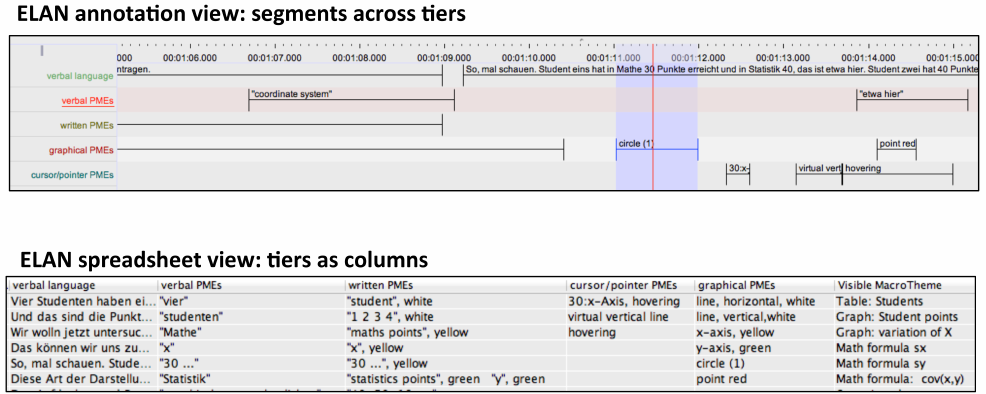
Figure 2. Extract of annotation tiers for the beginning of Video 1